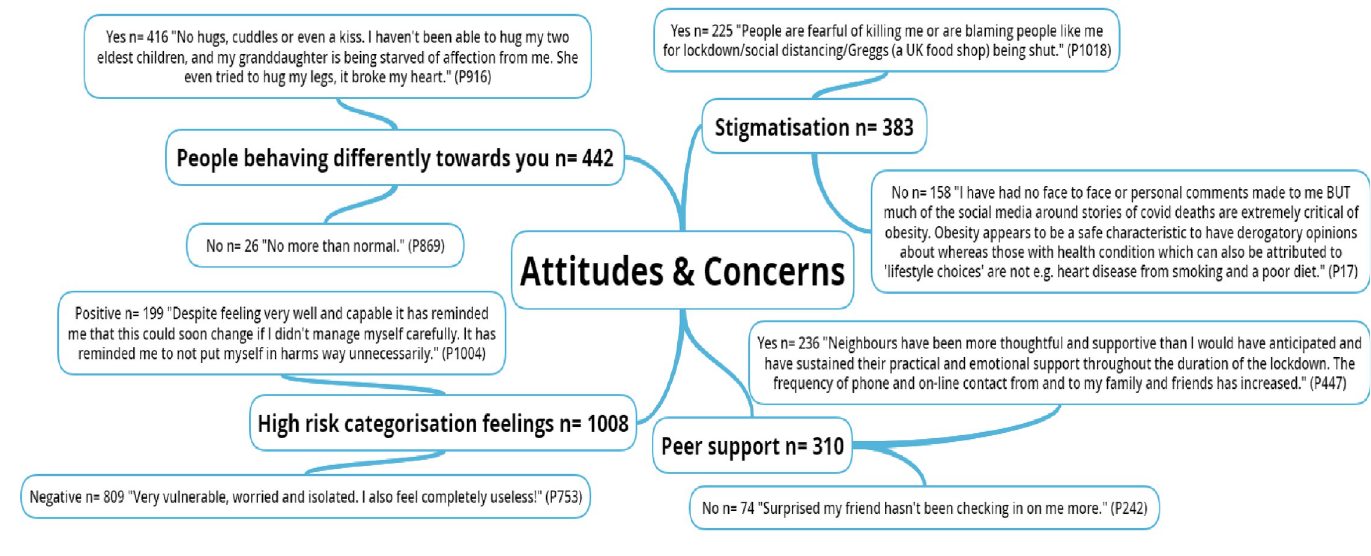
Fig 2. Exploring the attitudes and concerns of UK adults at high risk of severe illness during the COVID-19 lockdown.